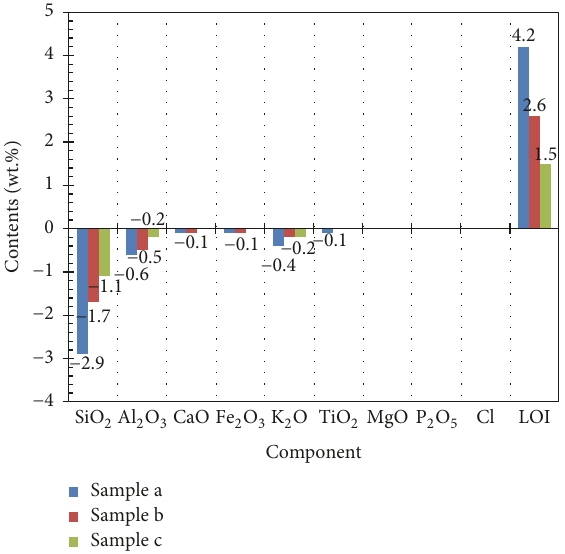
Figure 7: Variation of chemical compositions after